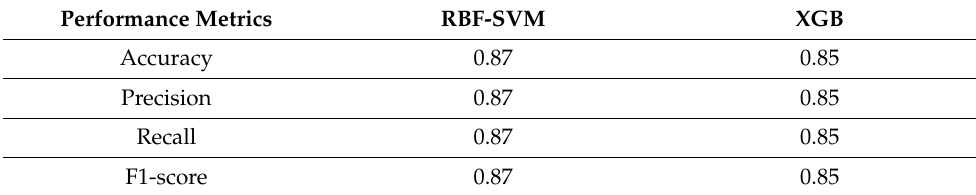
Table 3. Performance metrics for RBF-SVM and XGB.